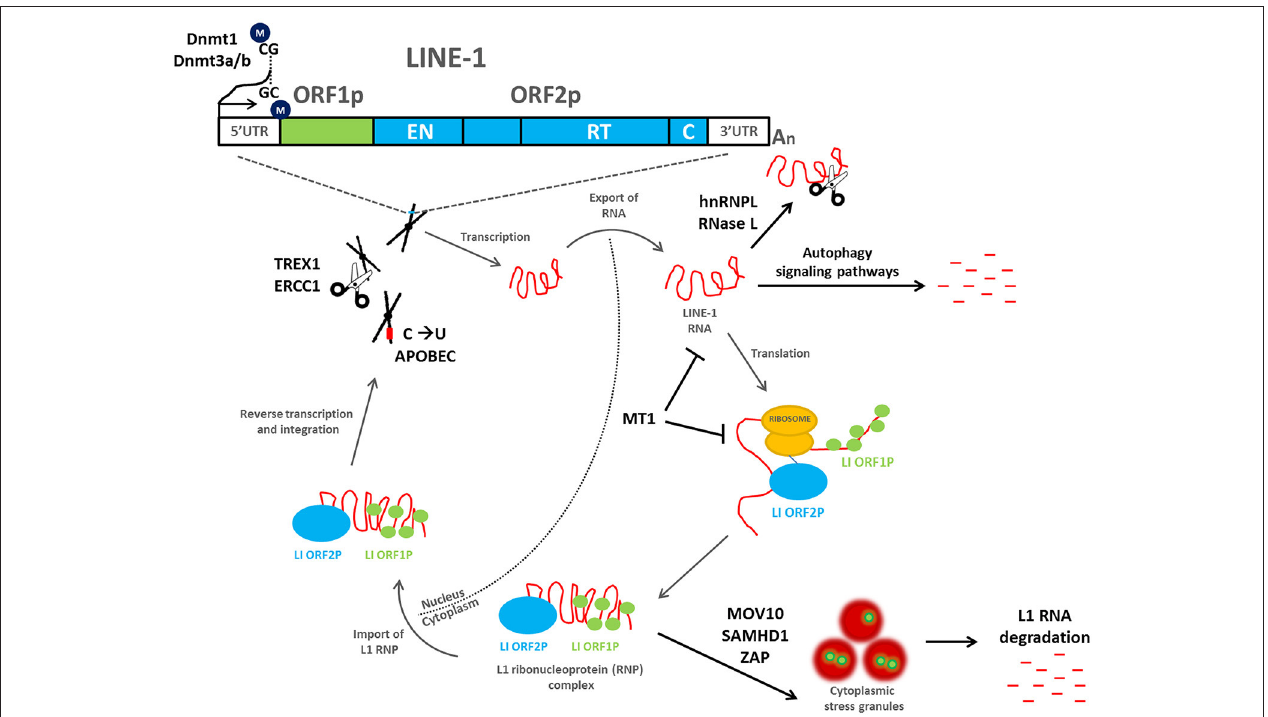
FIGURE 1 | Mobilization of L1 retrotransposons and the cellular mechanisms that inhibit their retrotransposition. A full-length L1 retrotransposon contains a 5 ′ untranslated region, two non-overlapping open reading frames (ORF1 and ORF2), and a 3 ′ untranslated region that ends in a poly (A) tail. ORF1 encodes a 40kDa RNA-binding protein, whereas ORF2 encodes a 150kDa protein (ORF2p) with demonstrated endonuclease (EN) and reverse transcriptase (RT) activities. During a cycle of retrotransposition (gray arrows), L1 is transcribed and exported into the cytoplasm, where translation occurs. ORF1p and ORF2p preferentially bind to their own mRNA and form ribonucleoprotein (RNP) complexes. The L1 RNP gains access into the nucleus, where the ORF2p endonuclease domain cleaves genomic DNA to expose a 3 ′ -hydroxyl residue that is used as a primer by the L1 reverse transcriptase to copy the L1 mRNA, a mechanism that has been termed target-primed reverse transcription (TPRT). The resulting cDNA is then inserted into a novel region in the genome. A number of host cell defense mechanisms exist to inhibit L1 retrotransposition (black arrows), including L1 DNA methylation, mutation, and/or degradation, L1 RNA degradation, inhibition of L1 RNP formation, and/or localization to stress granules, and autophagy signaling pathways. All are capable of inhibiting L1 and preventing its mobilization throughout the human